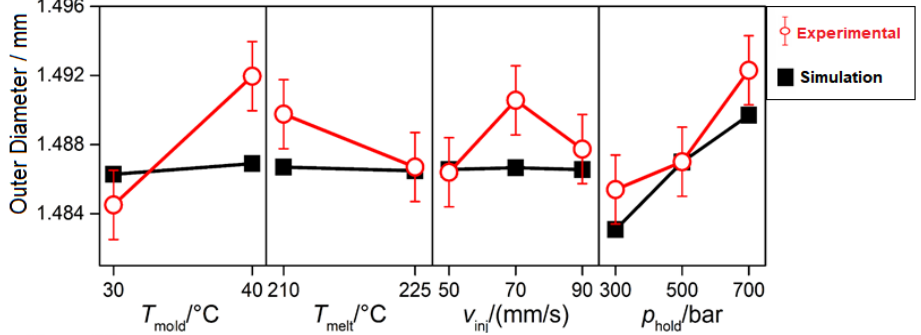
Figure 7. Main effects plot of the process factors on the outer diameter of the micro-ring [31].